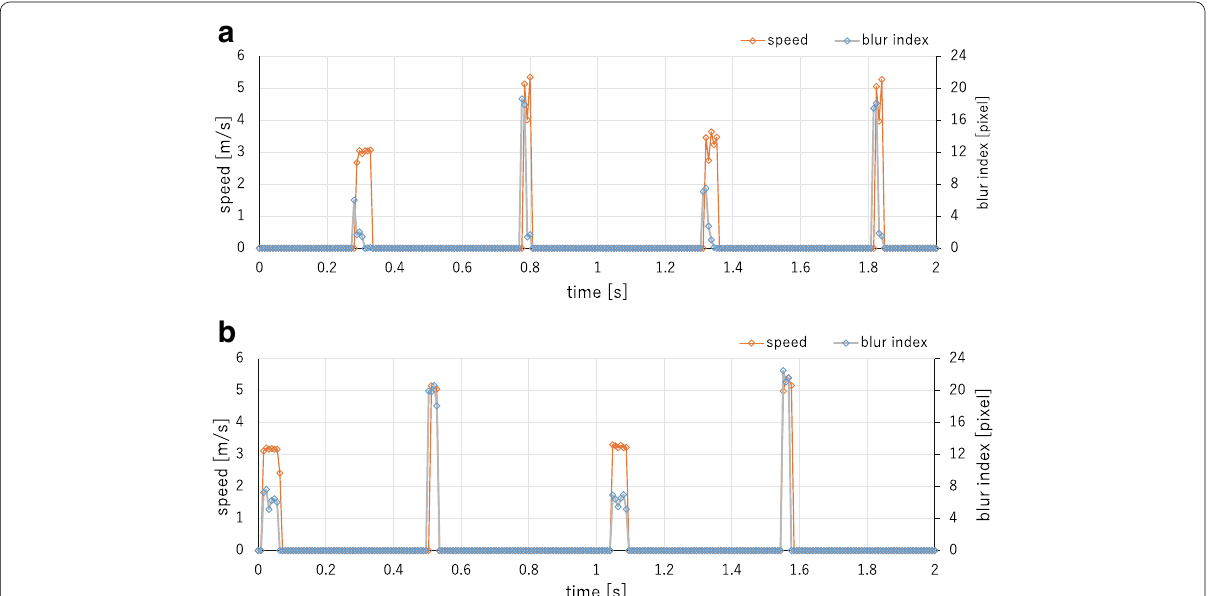
Fig. 19 Estimated speed and motion-blur index when table tennis balls were thrown at variable speeds. a With tracking (IT). b Without tracking